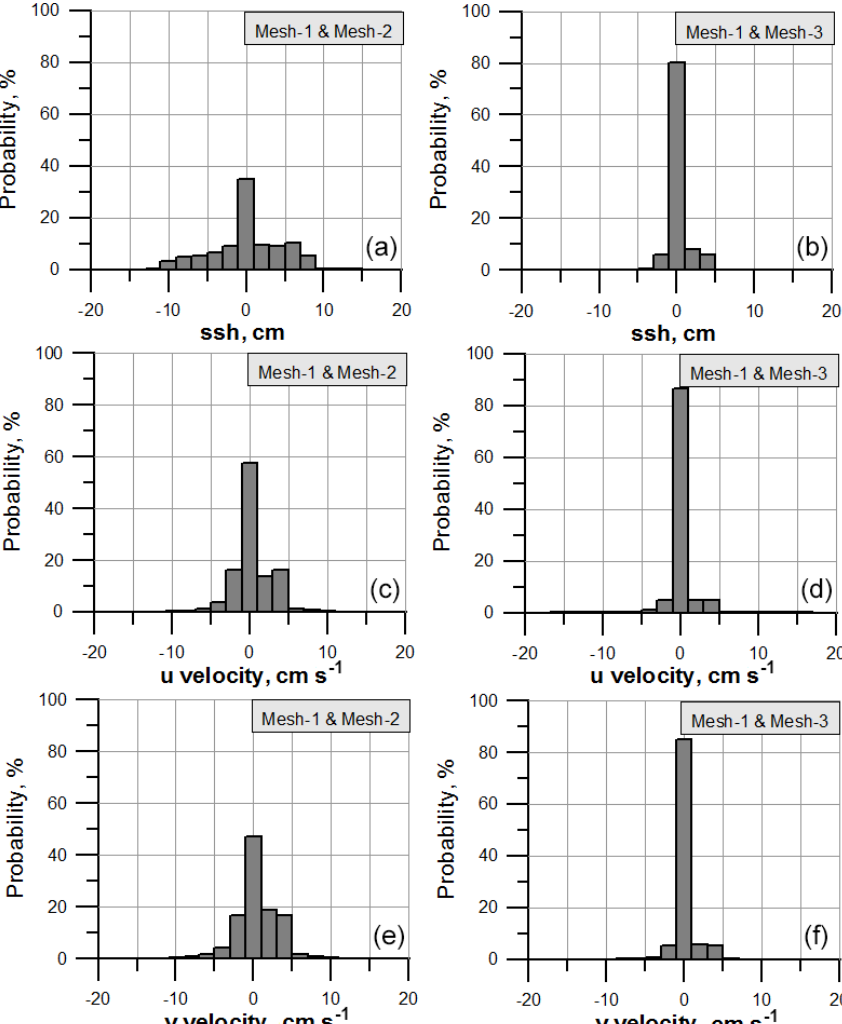
Figure 7. Histograms of the difference between solutions for the tidal cycle of the M 2 wave on MESH-1 and MESH-2 (a, c, e) and on MESH-1 and MESH-3 (b, d, f) . Top, middle, and bottom rows correspond to the difference in elevation and the u and v components of velocity,